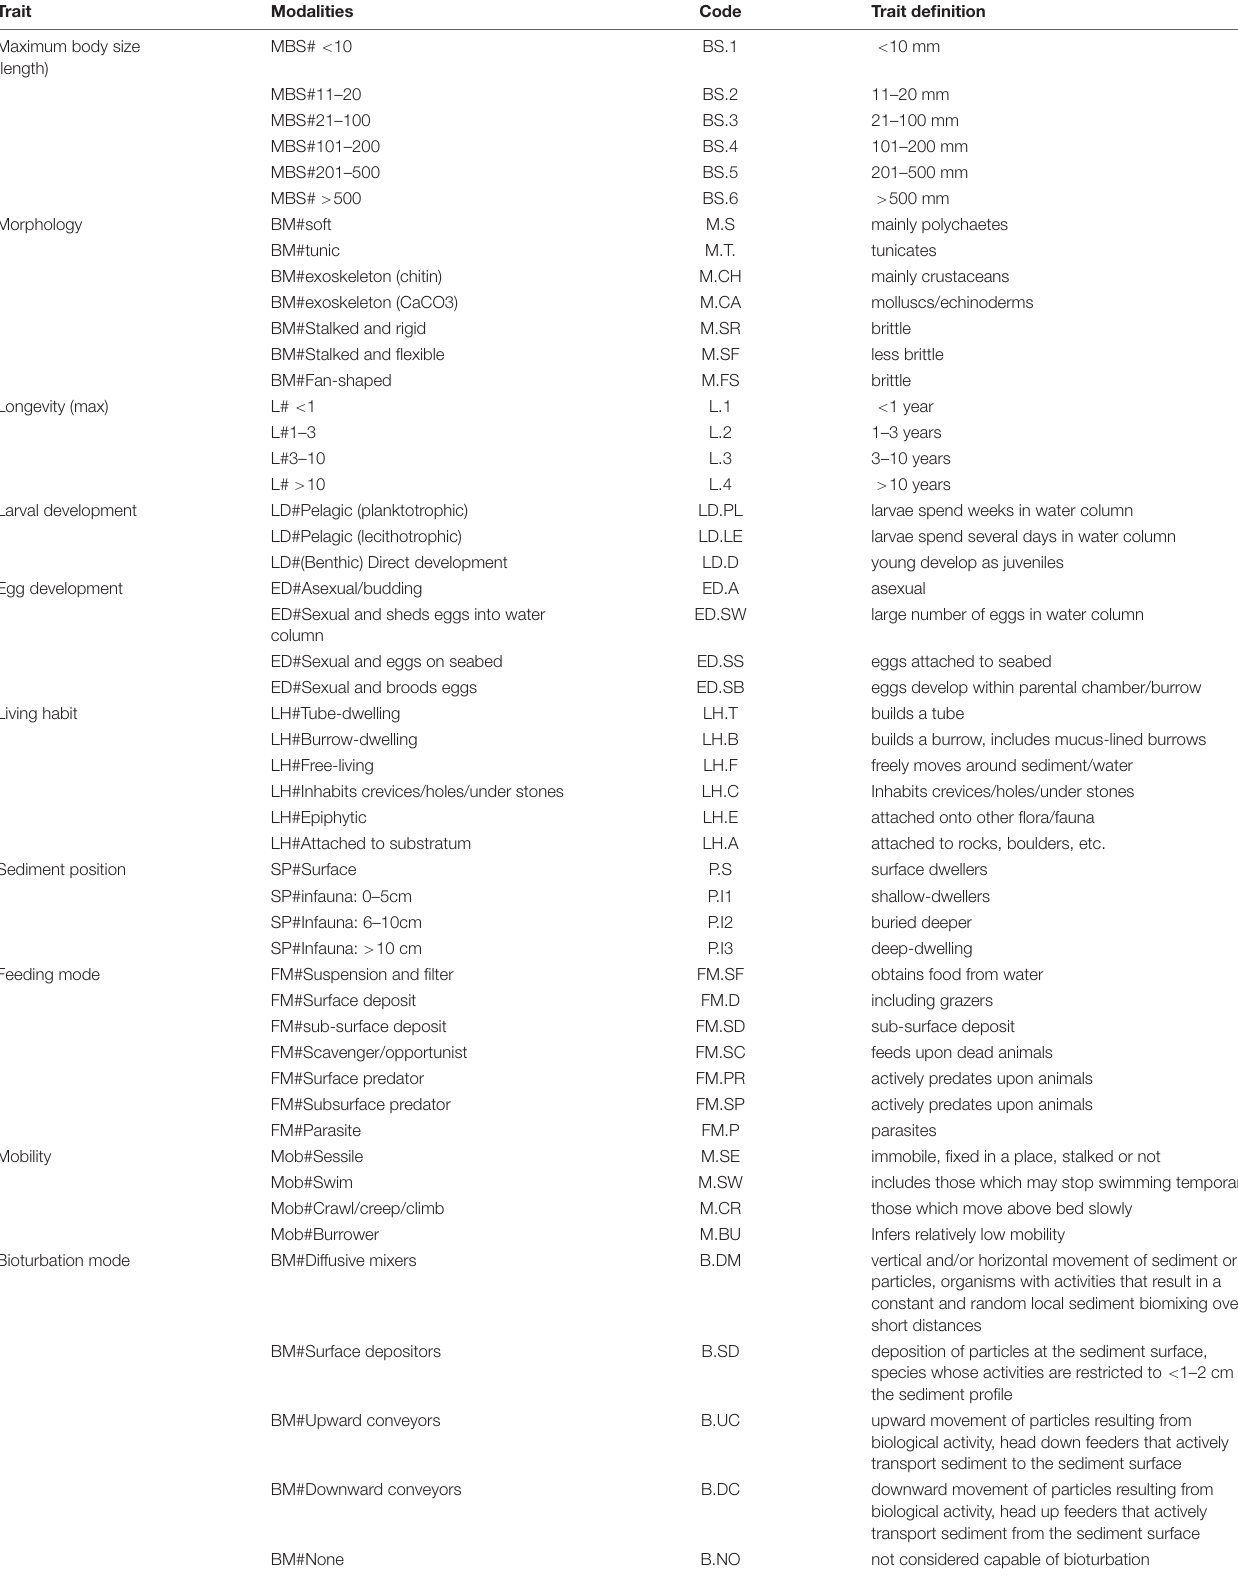
TABLE 2 | Description of traits and trait modalities used in the biological trait analysis. Trait